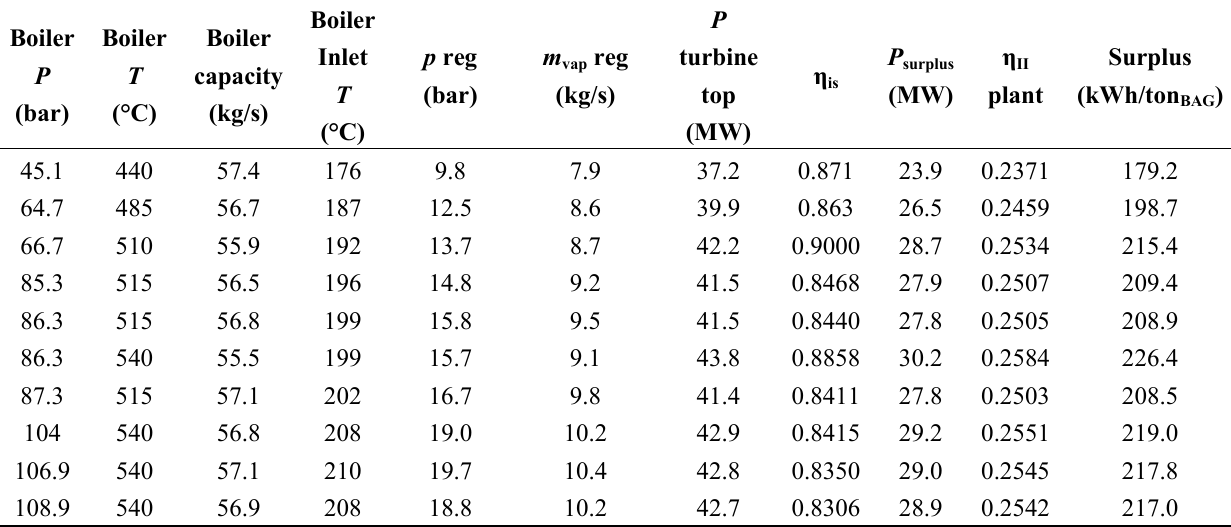
Table 5. Results of optimization for repowering with Option 1 at different boiler